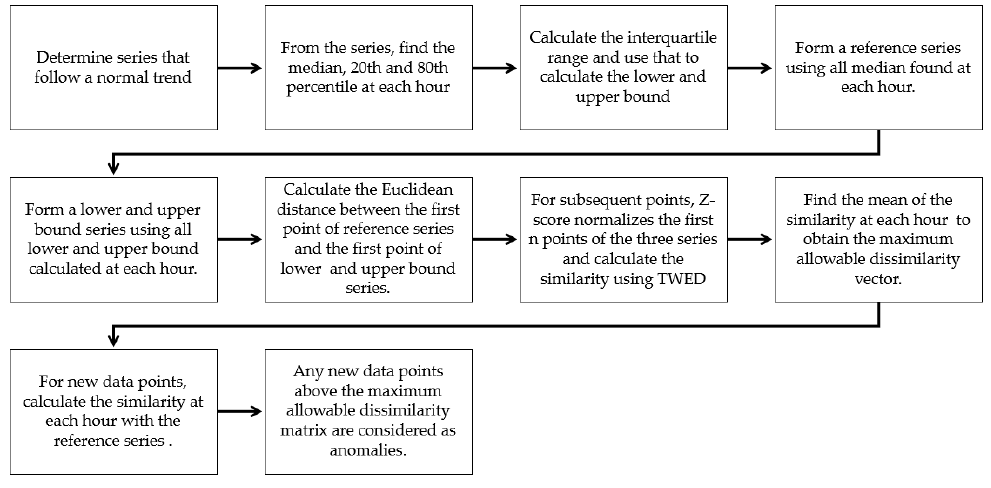
Figure 8. Median of extracted weekday and weekend water demand trend with upper and lower bound.